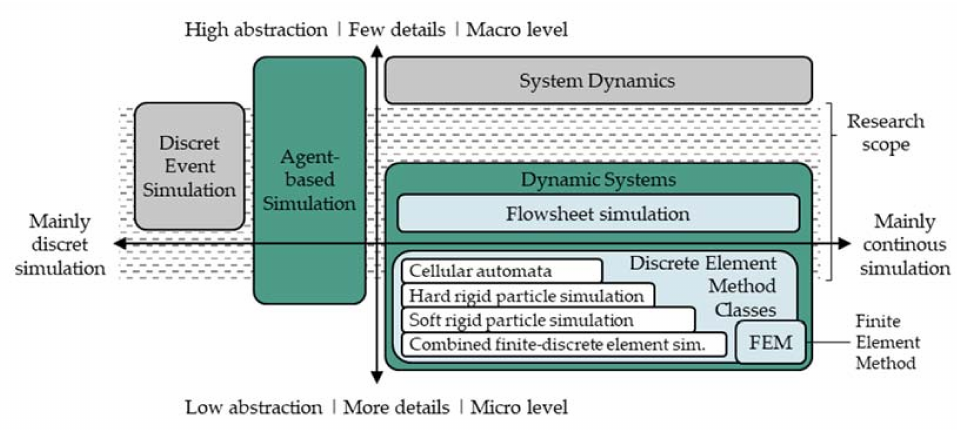
Figure 1. Typical dynamic simulation approaches for the tableting process mapped on the simulation modeling paradigms (following